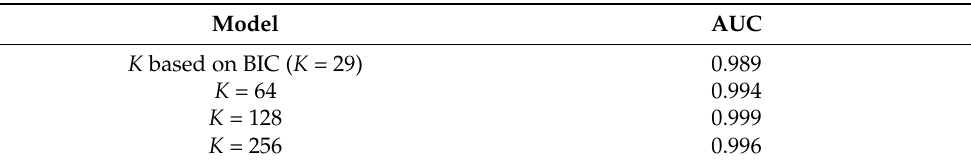
Table 8. AUC of each